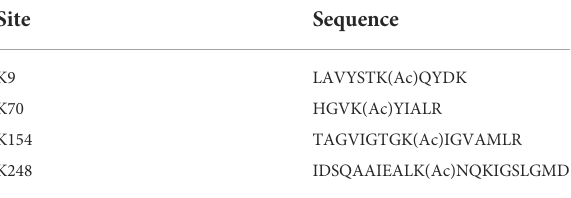
TABLE 2 Identi fi cation of acetylated LdhA peptides by mass